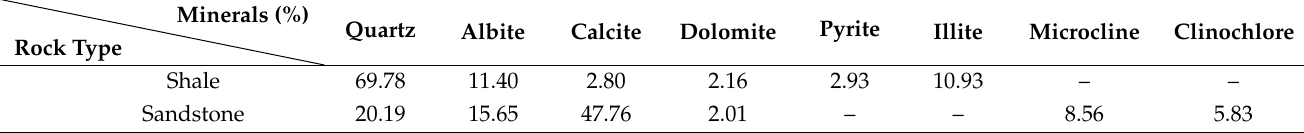
Table 2. Mineral composition of selected shale and